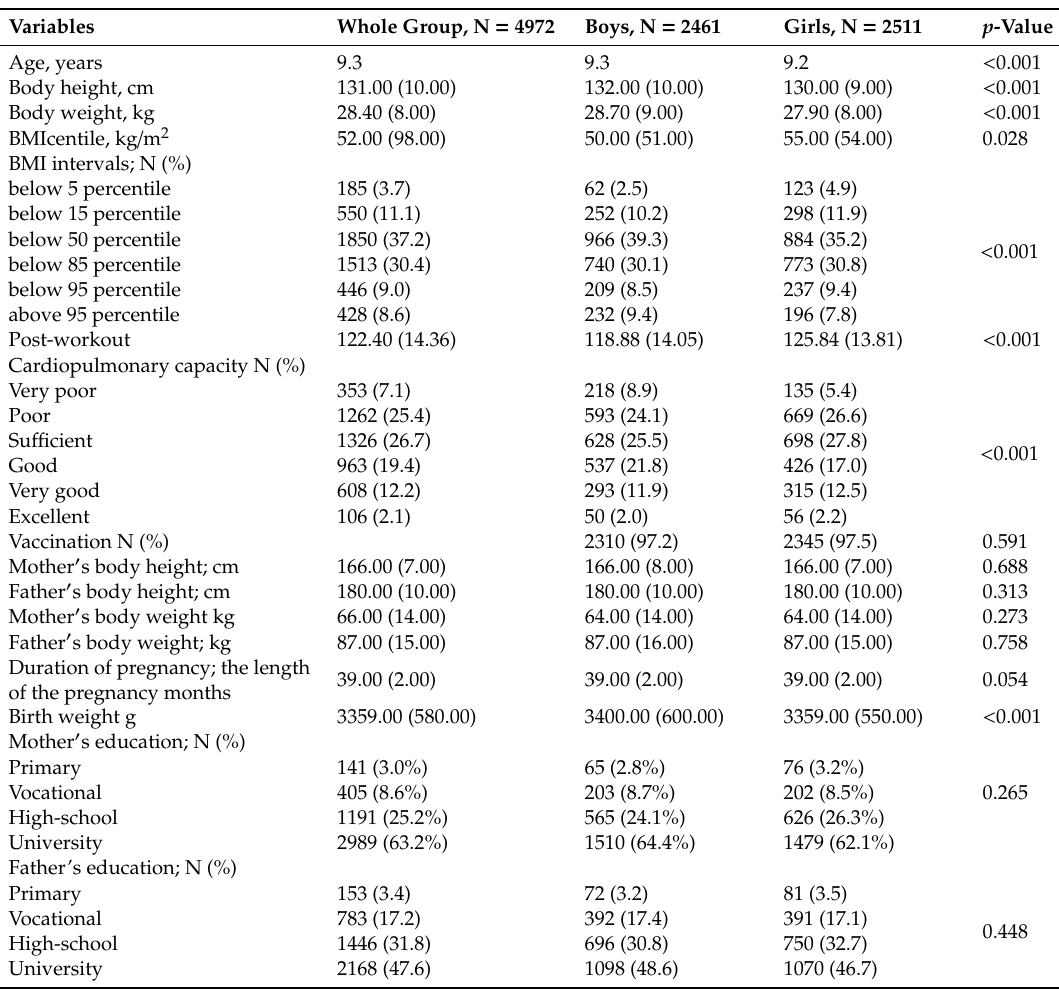
Table 1. Characteristics of the examined children including gender di ff erences, N (%) or M (SD).